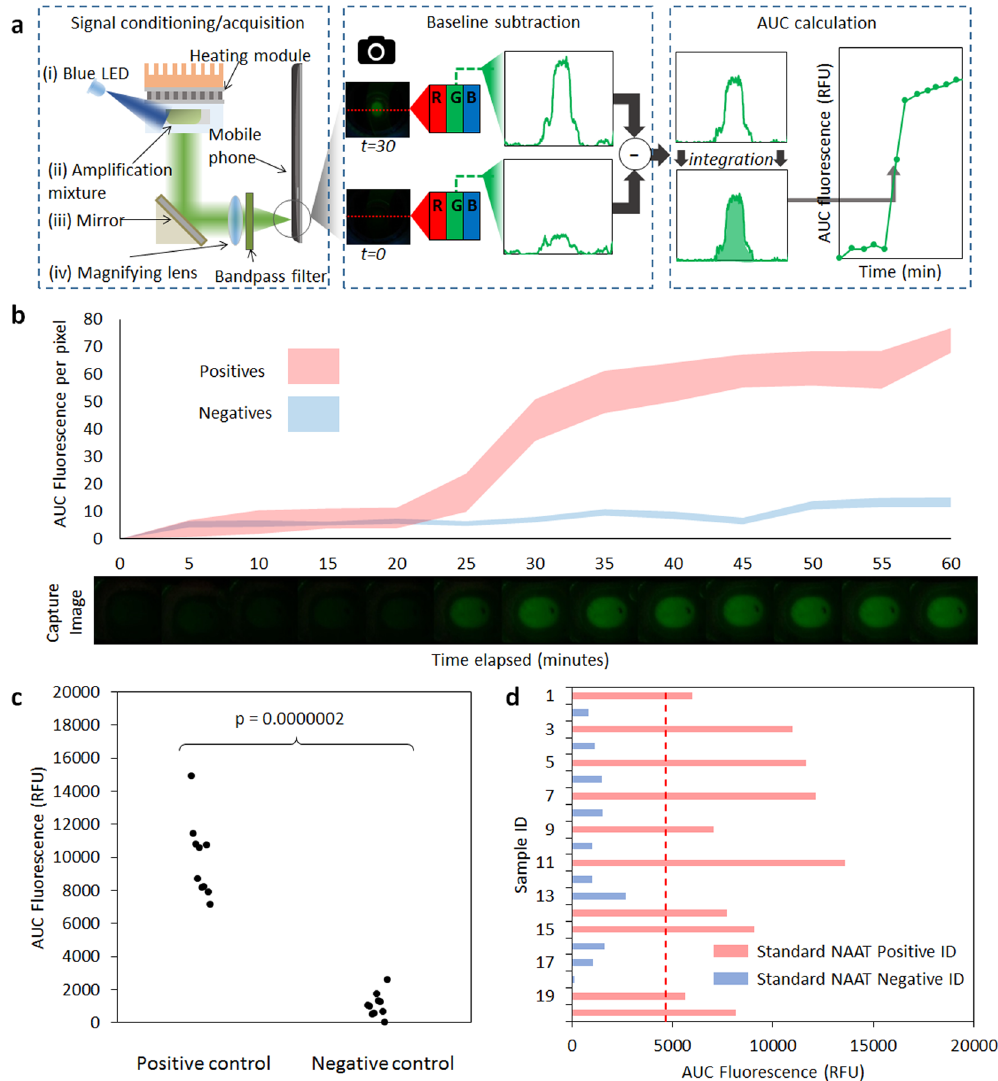
Figure 3. Signal acquisition and platform validation study. ( a ) Image processing algorithm on the mobile phone. Initially, image is acquired at the start of the incubation (time = 0). Signal acquisition is performed using an optical pre-processing signal relay chain as described in Fig. 1c. Subsequent images are captured and segmented to extract information from a single row of pixels across the incubation chamber. Only the green value of the RGB data is used. Data acquired at each time point are normalized by subtracting segmented data from time = 0. Afterwards, the area under the resultant vector is integrated in order to yield a single value, which is used either for end-point analysis or plotted sequentially over time for real-time monitoring. ( b ) Real- time monitoring of select deblinded clinical samples using time-lapse image acquisition. Positive samples show development of signal and are clearly differentiated from signal developed by negative samples beginning at approximately 20 minutes of incubation. Shaded areas represent upper and lower bounds of AUC fluorescence (n = 3). Bottom panel shows image of fluorescence developing over time in a positive control reaction in droplet cartridge. ( c ) Reproducibility test showing signal generated from chlamydia DNA target-positive and negative cartridges (n = 10 each). Welch’s two sample t-test yields p < 0.000001. ( d ) Validation of the mobiNAAT platform using blinded vaginal swab samples obtained from an equal number of chlamydia-positive and -negative individuals (n = 20). AUC fluorescence levels of swab samples that are positive (blue) or negative (orange) are shown. Welch’s two sample t-test yields p < 0.00001. Classification threshold (red dotted line) is established using signals obtained from a set of control samples (n =